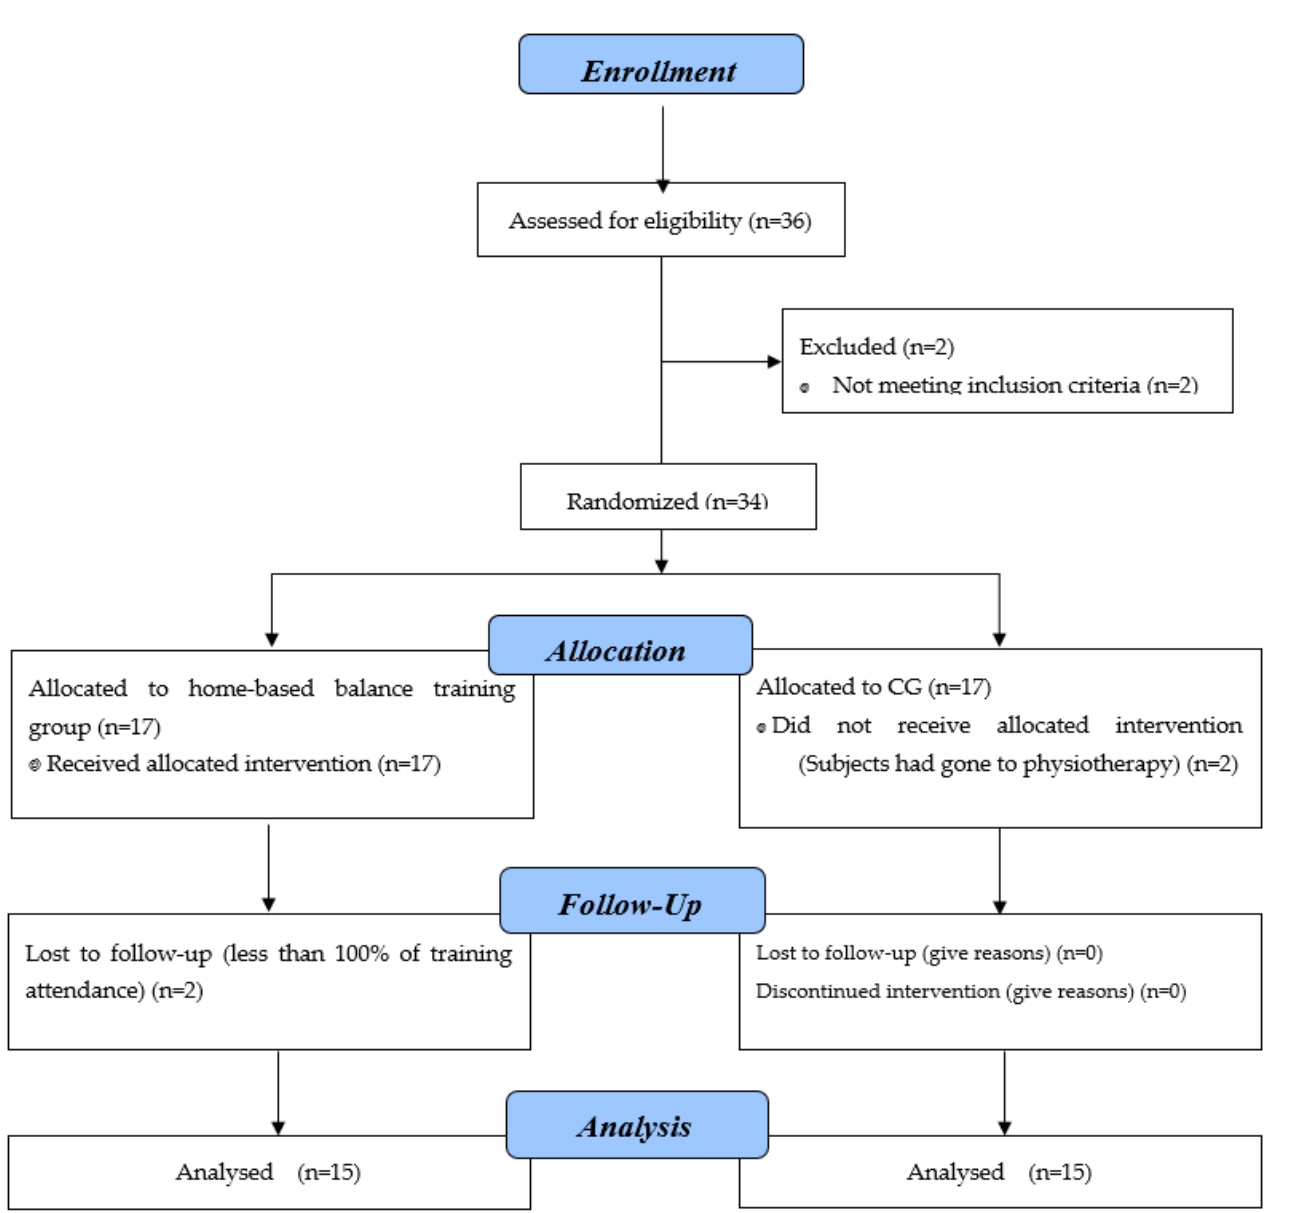
Figure 1. CONSORT flow chart of participants for recruitment, application, follow-up and analysis.